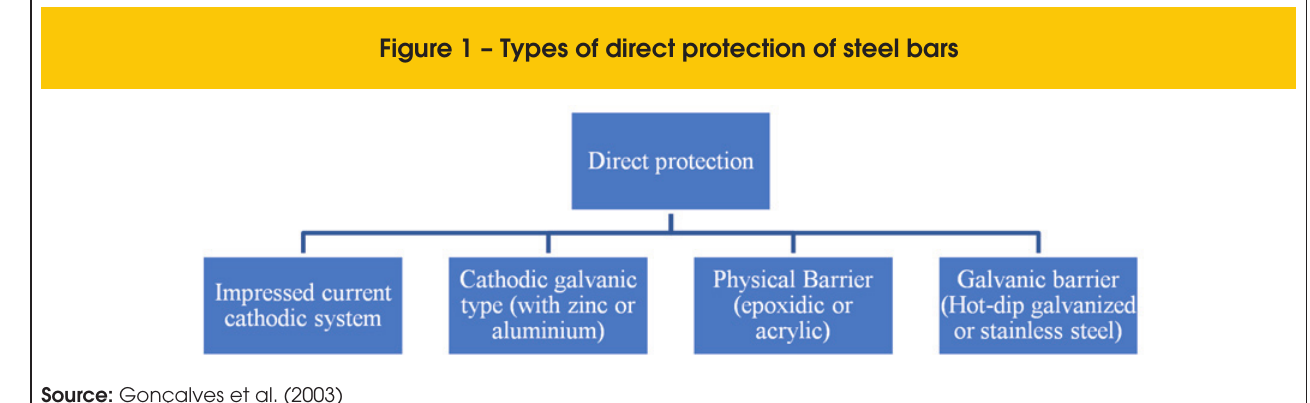
Figure 1 – Types of direct protection of steel